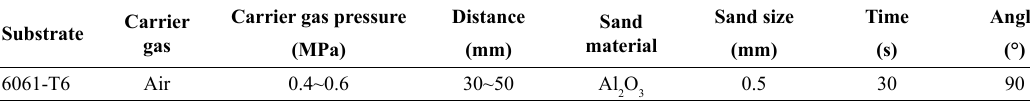
Figure 10. Process of the TWAS spraying Ni-Al composite coating for (a) and (b). Table 2. Related sandblasting parameters before arc